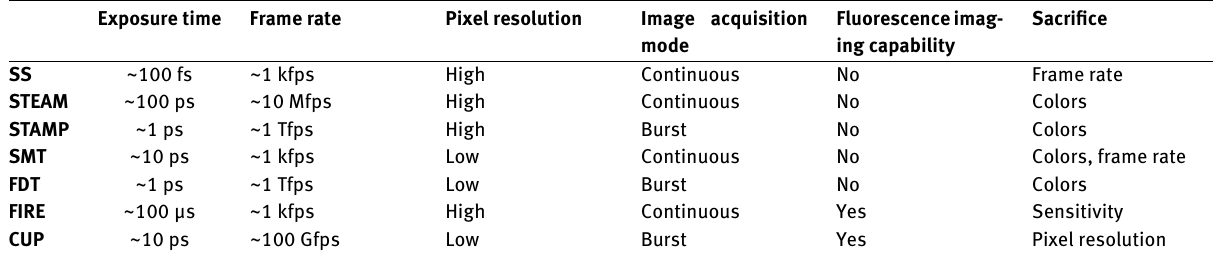
Table 1. Comparison in terms of imaging capabilities between SS, STEAM, STAMP, SMT, FDT, FIRE, and CUP. SS, STEAM, SMT, and FIRE are continuous imaging methods while STAMP, FDT, and CUP are burst imaging methods. Exposure time Frame rate Pixel resolution Image acquisition Fluorescenceimag- Sacrifice mode ing capability SS ~100 fs ~1 kfps High Continuous No Frame rate STEAM High Continuous